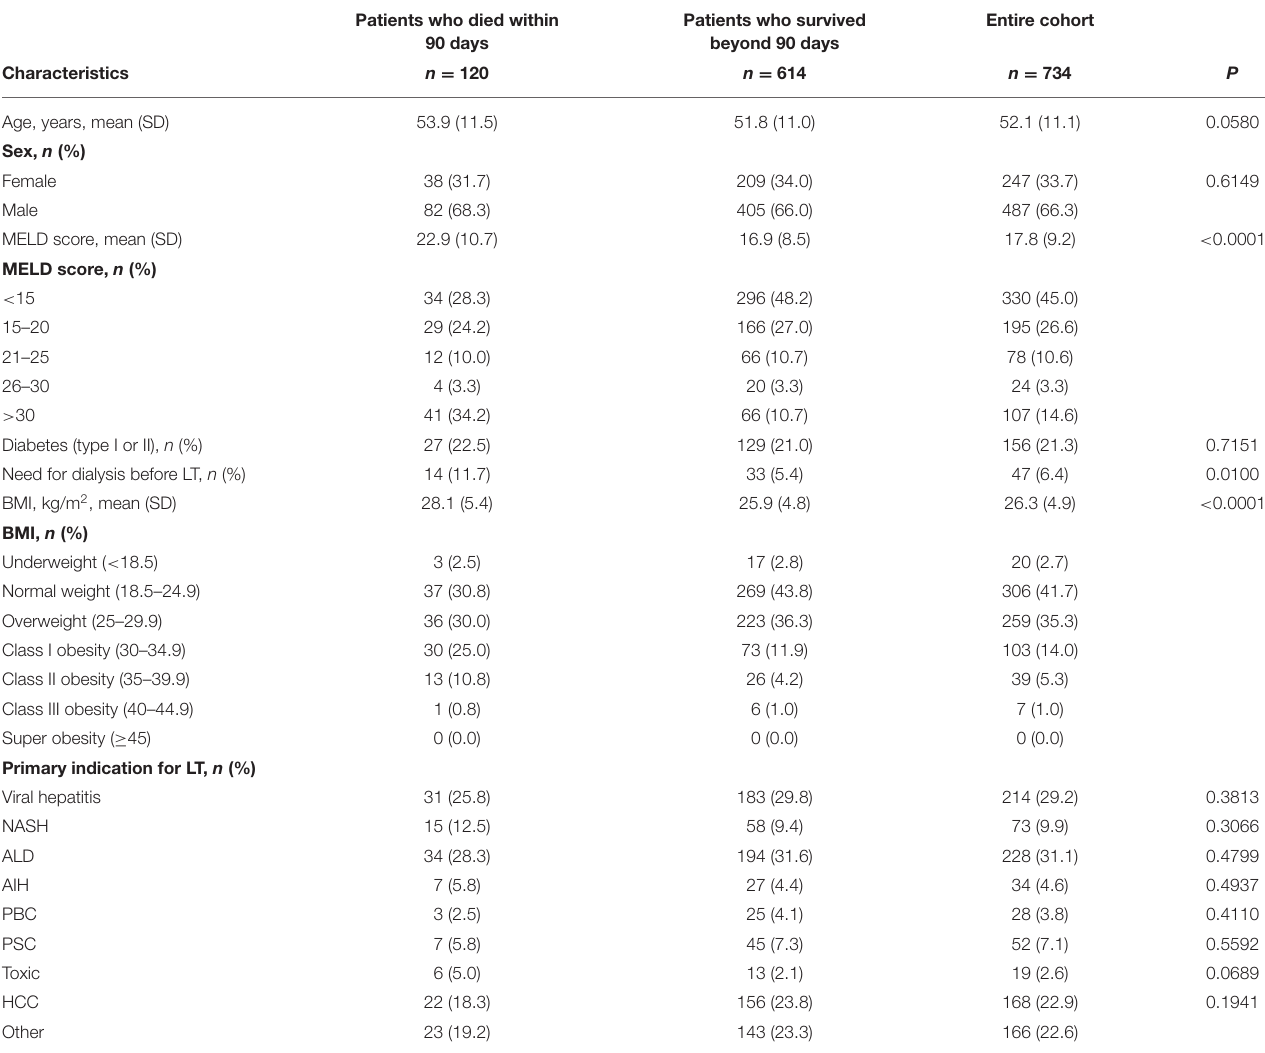
TABLE 1 | Demographic and clinical characteristics of patients who deceased within 90 days, patients who survived beyond 90 days after liver transplantation (LT) and the entire study population,